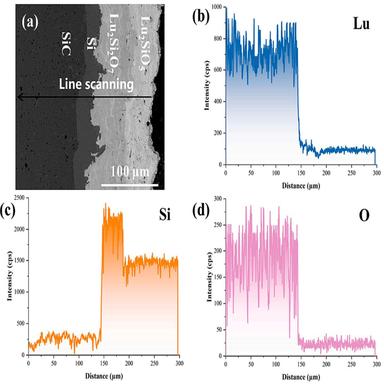
(a) Cross-sectional morphology of Lu2SiO5/Lu2Si2O7 coatings, (b-d) Results of Lu, Si, O line scan in (a).